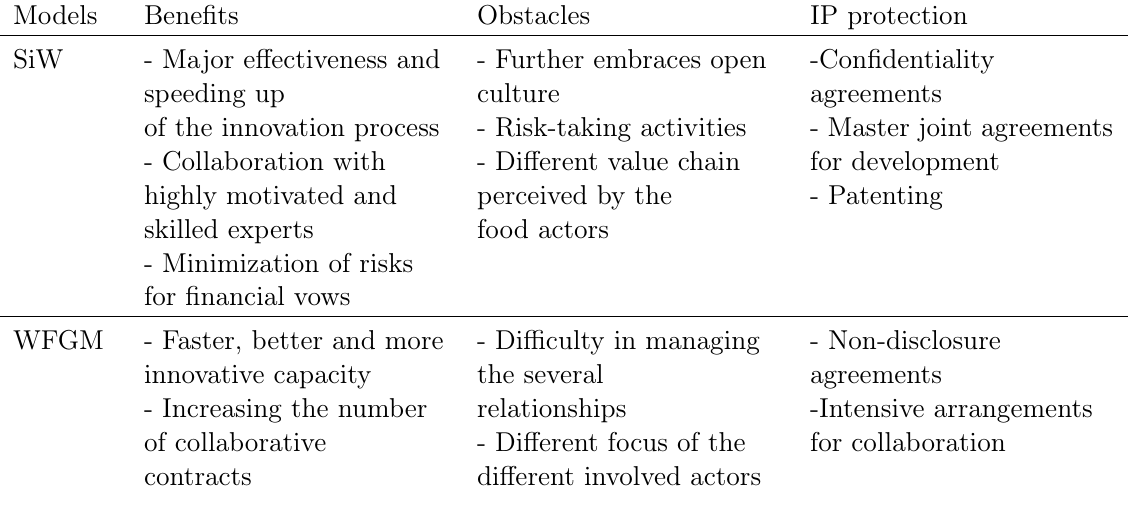
Table 2. Key characteristics of the SiW and WFGM models